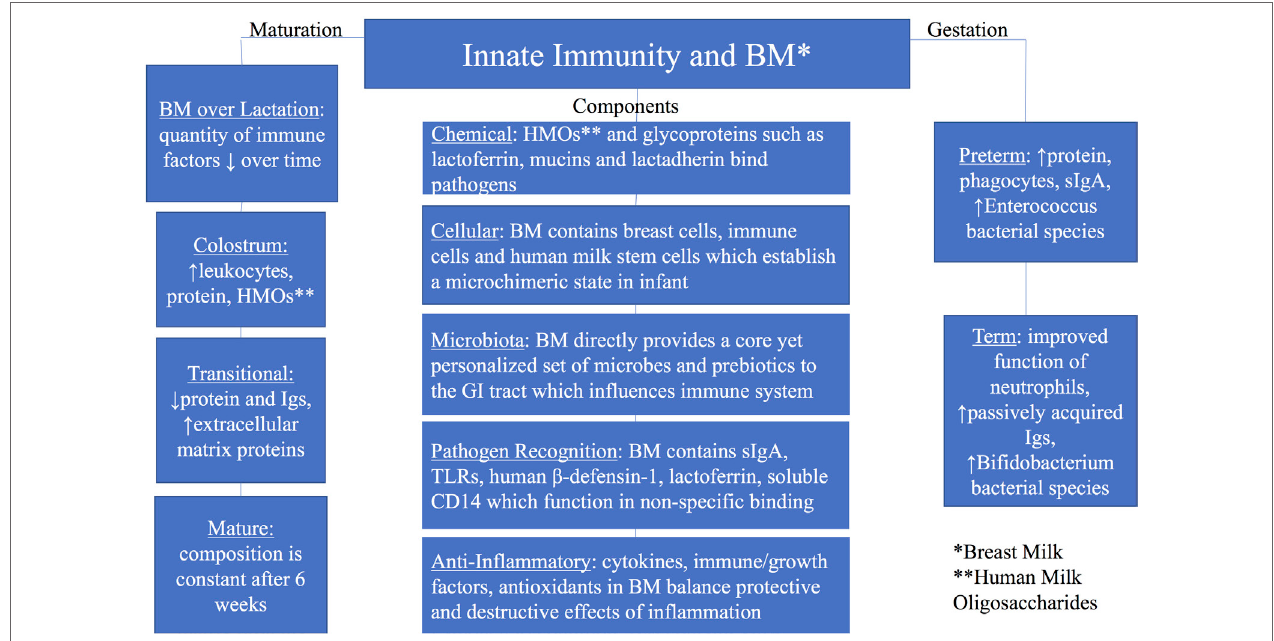
FigURe 1 | Summary of innate immunity and breast milk with groups including components of the innate immunity, maturation of breast milk over lactation, and breast milk by gestation (preterm and term)